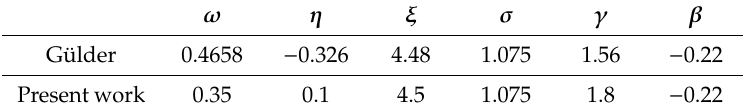
Table 1. Fitting coe ffi cients of the laminar flame speed.